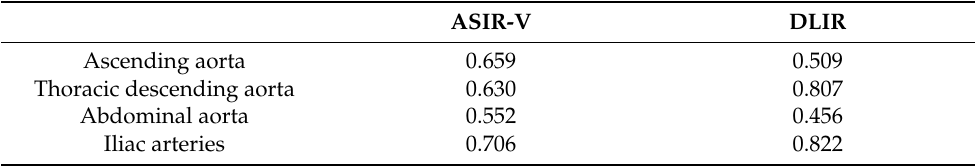
Table 4 weighted kappa values are shown for interobserver agreement of subjective imaging quality ratings. ASIR-V = adaptive statistical iterative reconstruction V, DLIR = deep learning-based image reconstruction. Table 5. Subjective image quality.